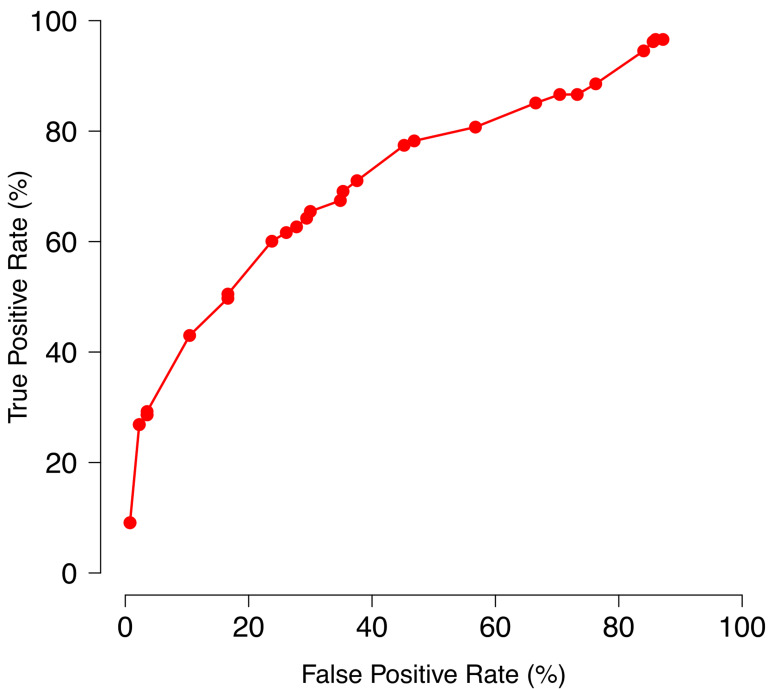
Model performance for case-control classification of autism using rare CNVs, with greater number of splits.Legend identical to
Figure 9, except that here the graph is comprised of 30 measures because features are scored out of 30, rather than in
Figure 9, where features are scored out of 9.